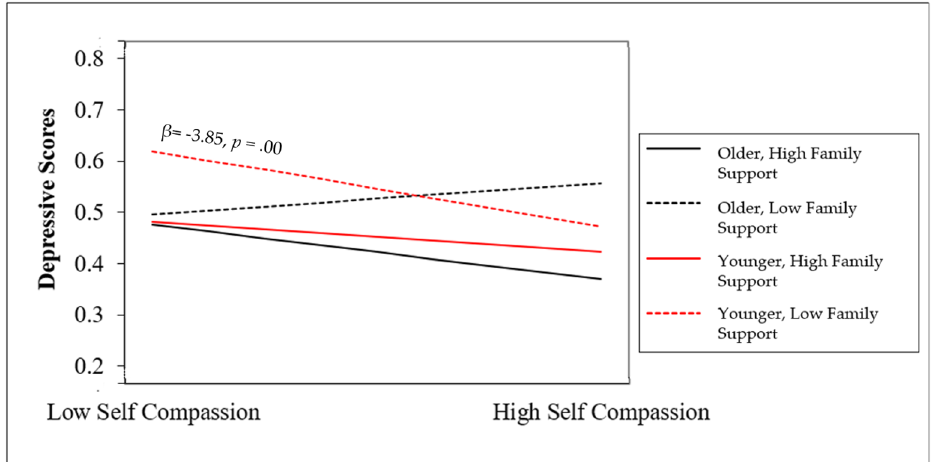
Figure 1. Interaction between self-compassion, family support, and age on depressive symptoms.